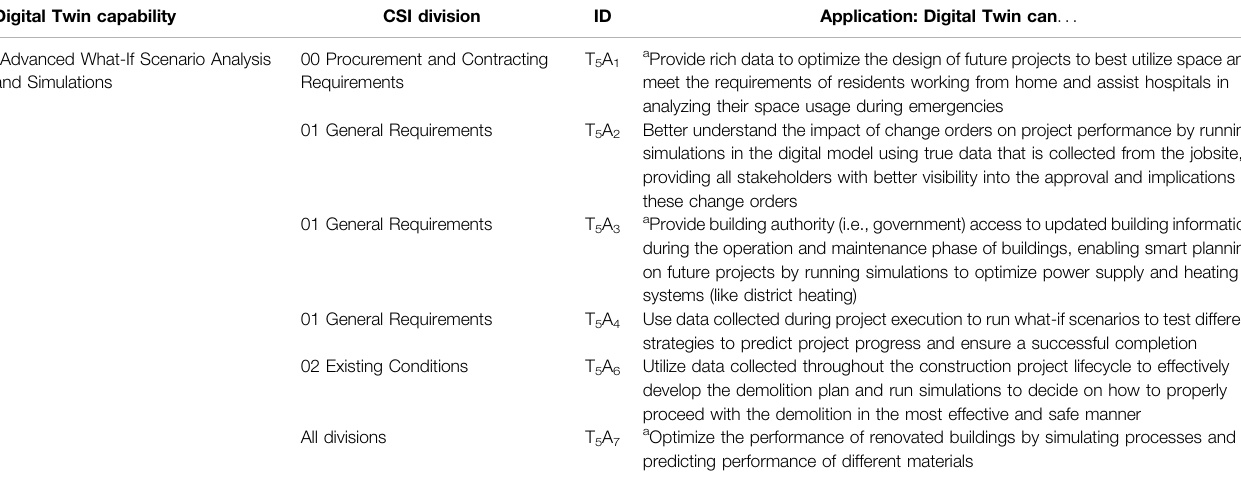
TABLE 7 | Digital Twin capability of Advanced What-If Scenario Analysis and Simulations and the identi fi ed applications. Digital Twin capability